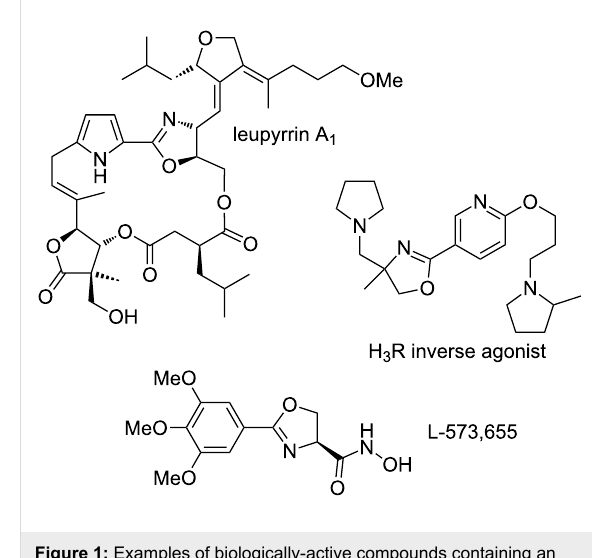
Figure 1: Examples of biologically-active compounds containing an oxazoline ring.